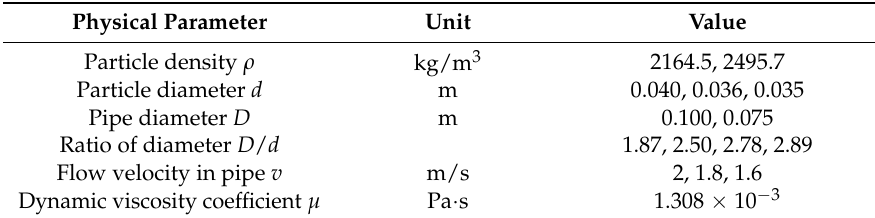
Table 2. Parameters for vertical incipient motion tests of single particle.